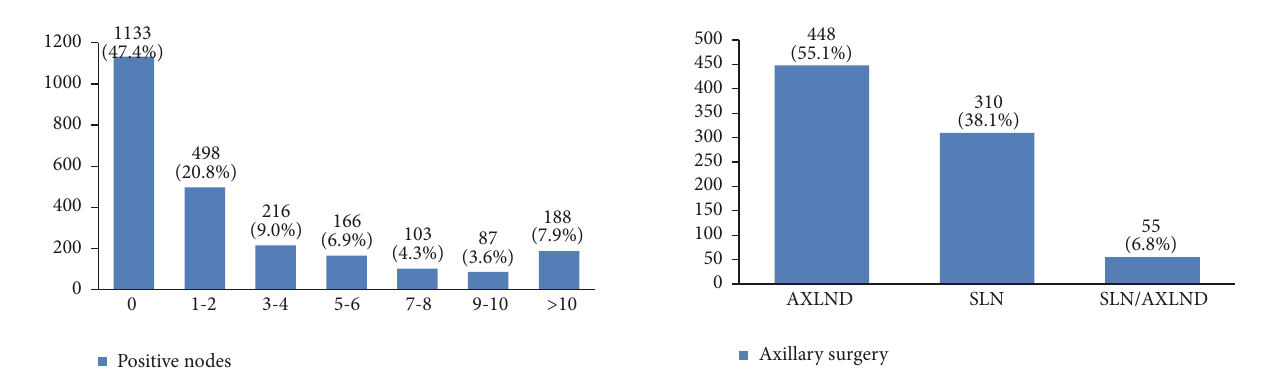
Figure 19: The number of pathologically positive nodes in the studied cases.